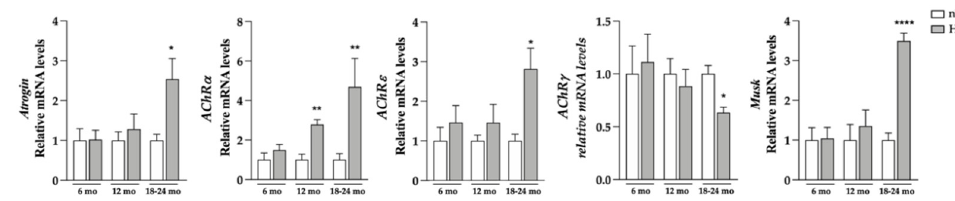
Figure 2. Neuronal expression of CHMP2B intron5 induces a modest increase in the expression of denervation markers. Denervation markers were evaluated at three ages. HE mice were compared to age-matched nTg mice. Histograms represent means ± SEM; Atrogin : n = 4–6/group. AchR α : n = 12/group. AchR ε , AchR γ and Musk : n = 6–8/group * p < 0.05, ** p < 0.01, **** p < 0.0001, Student’s t -test.